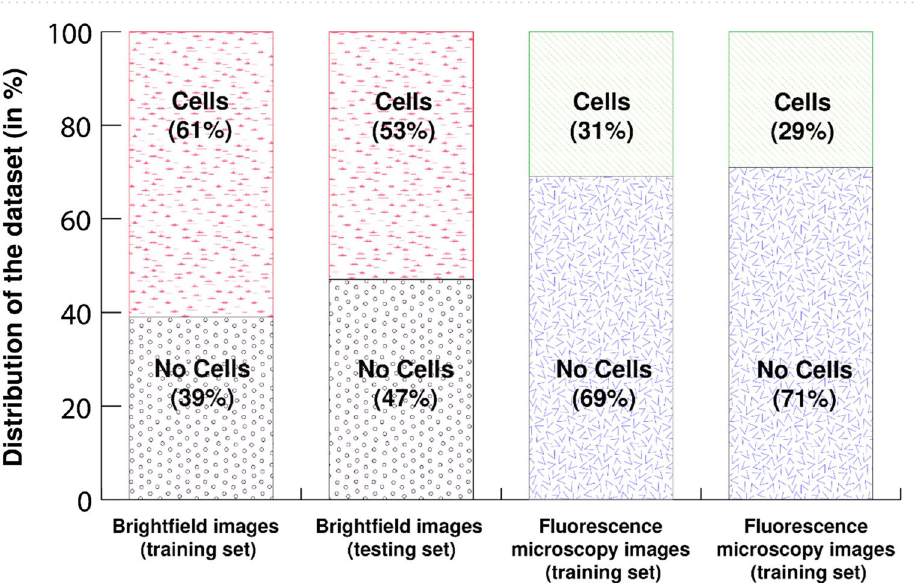
Figure 8. The distribution of images in either of the datasets, according to the presence of cells in the microwells. Our datasets had a greater number of images in which there were cells trapped. However, in the latter part of the experiments, when we chose fluorescence microscopy images, we obtained images of microwell patterns where no cell trapping was observed for a majority section of the dataset, for both the training and testing set. This in turn has ensured that our model sufficiently learns from those images as well where the cells are not trapped in the